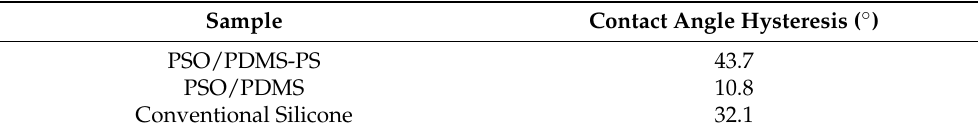
Table 2. The contact angle hysteresis of